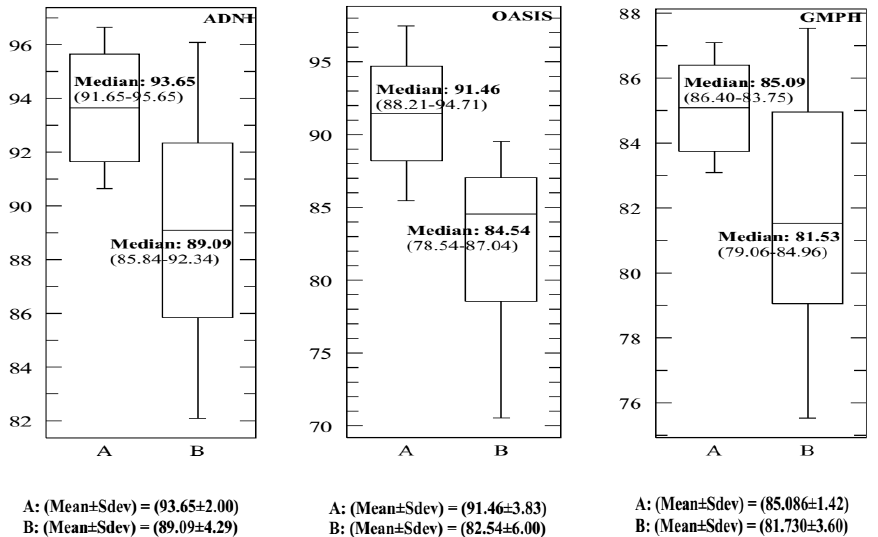
Figure 15. The corresponding Box-and-whisker plots of the descriptive statistics of the accuracy (AC) values for ADNI, OASIS and GMPH datasets with 20% additive noise, using 10-fold cross validation to evaluate the proposed SVDD classifier based on BCFCM/GA/PFCM segmentation approach (case A in figure). Comparison with SVM classifier, based on BCFCM/GA/PFCM (case B ).